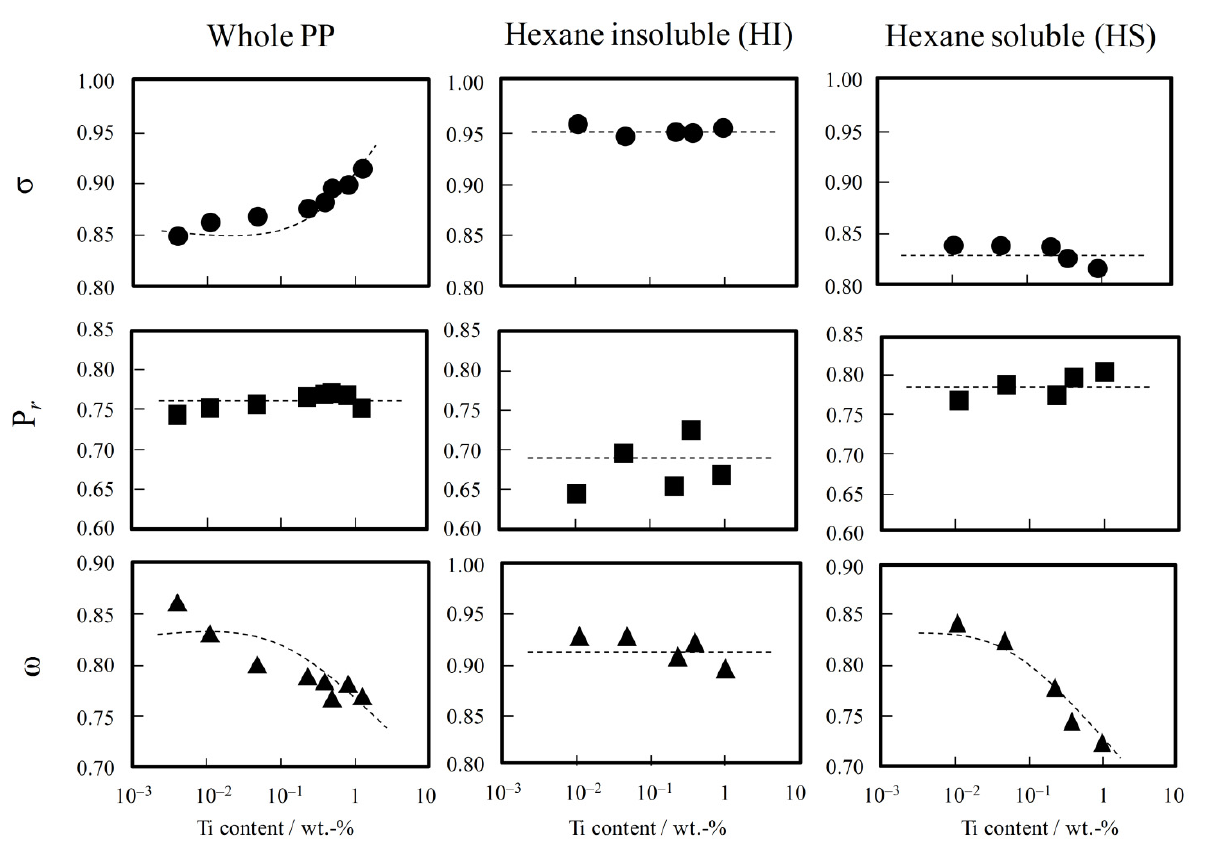
Figure 2. Fitting results of the two-site model for the pentad stereosequences of PPs produced by the model catalysts at different Ti